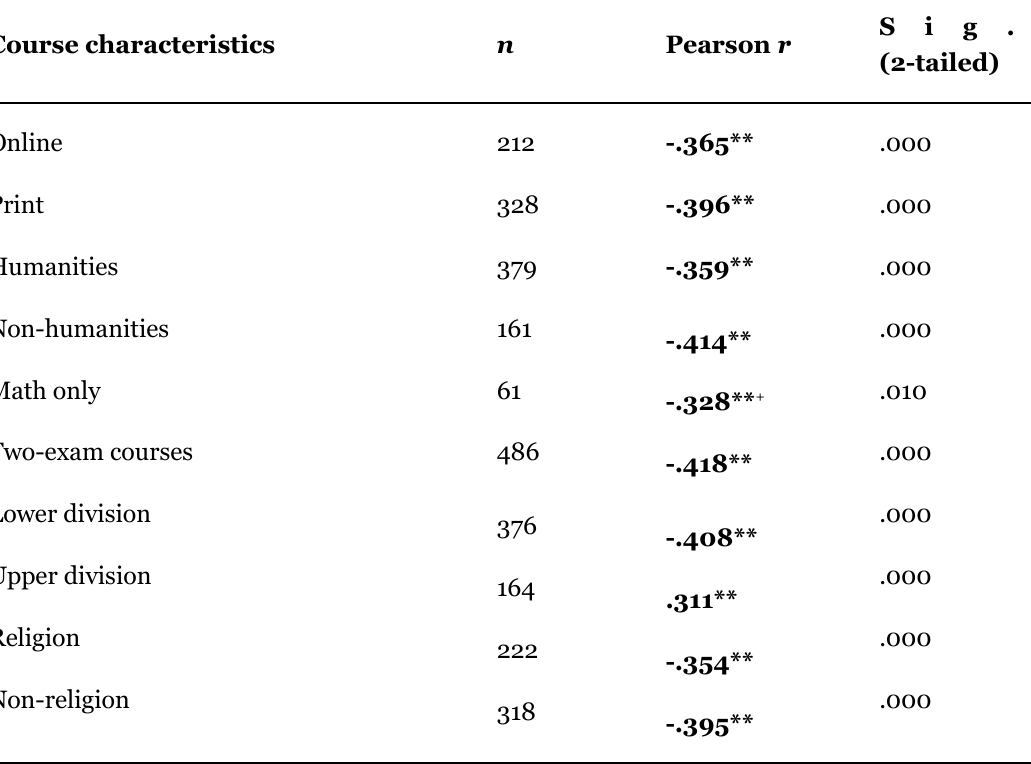
Replication of Relationship Analysis between Sequential Movement and Successful Completion in Subsets of Student